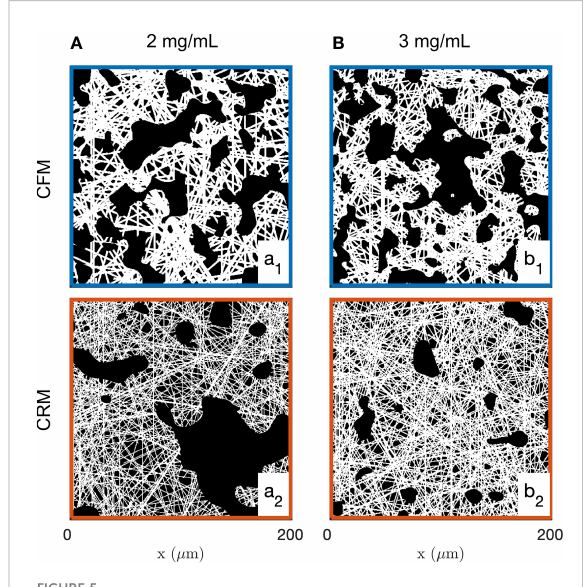
FIGURE 5 Realizations of the fi bre aggregate model, for the 2 mg/mL (a1, a2) and 3 mg/mL (b1, b2) gels, based on the average values of the parameters fi tted from the covariance of the CFM (a1, b1) and CRM (a2, b2) segmented